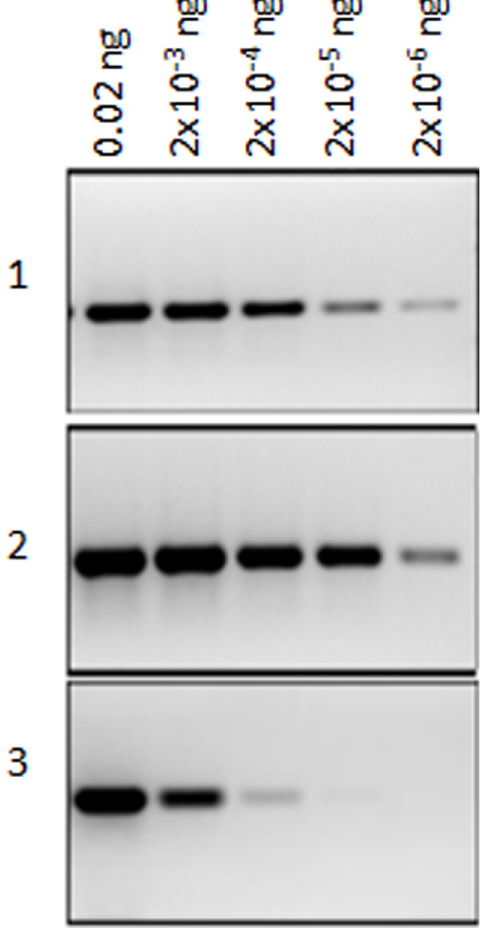
Fig 3. PCR- DPPIII detection limit based on ten-fold serial DNA dilutions. 1 : L . major (Ron44); 2 : L . infantum (IPT1); 3 : L . tropica (Bag17). For each DNA, ten- fold serial DNA dilutions starting from 0.02ng were input into the